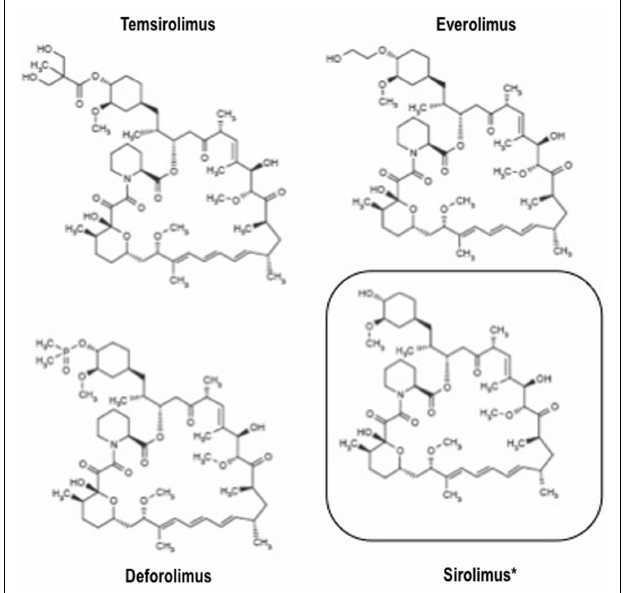
FIGURE 2 | Structure of clinically available mTOR inhibitors